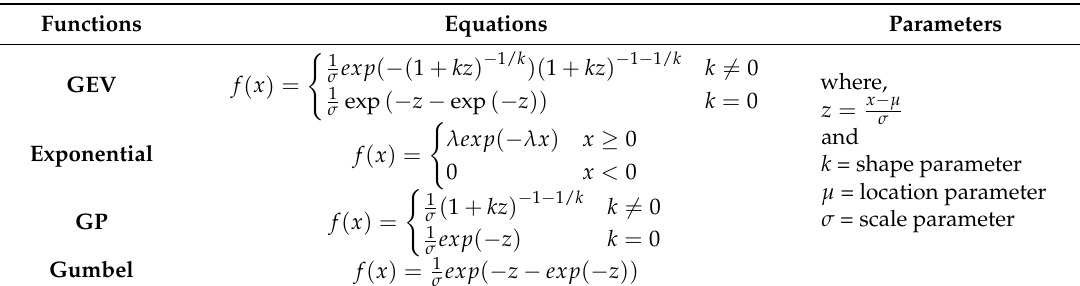
Table 2. The PDFs compared for selection of the best